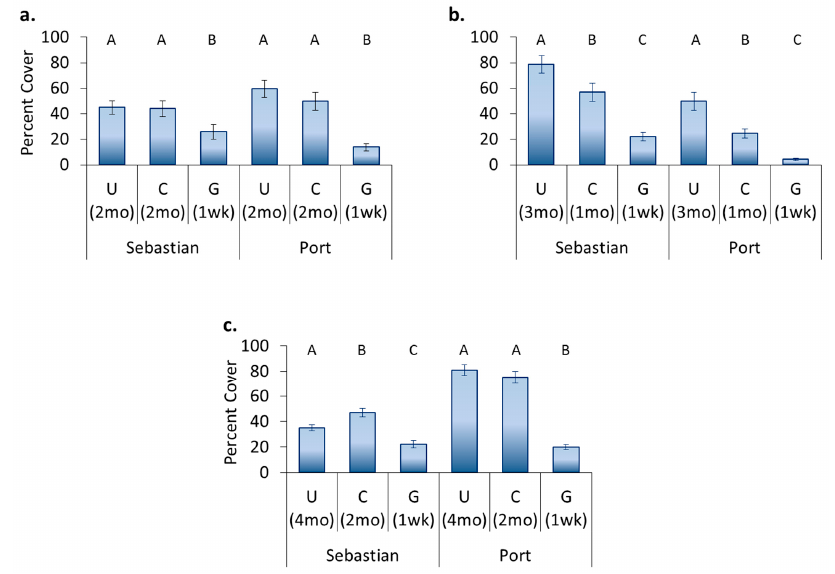
Figure 6. Differences in average, total macrofouling cover on IS700 due to treatment. ( a ) In May, groomed panels had significantly lower macrofouling cover than uncleaned (Sebastian p = 0.001; Port p < 0.001) or cleaned (Sebastian p = 0.002; Port p < 0.001) panels at both locations. ( b ) In June at both locations, uncleaned panels had higher macrofouling cover than cleaned or groomed panels and cleaned panels had higher cover than groomed panels ( p < 0.001). ( c ) In July at Sebastian, cleaned panels had significantly higher cover than uncleaned ( p = 0.04) or groomed ( p < 0.001) panels and uncleaned panels had significantly higher cover than groomed ( p = 0.02) surfaces. At the Port, groomed ( p < 0.001) panels had significantly lower macrofouling cover than uncleaned or cleaned panels. Error bars represent one standard error. The X-axis is treatment and the Y-axis is average percent cover. Treatments are uncleaned (U), cleaned (C) and groomed (G). The time in the parenthesis is elapsed time since treatment. Letters above the bars denote statistical significance (i.e., As are statistically similar to, but significantly different than, Bs).